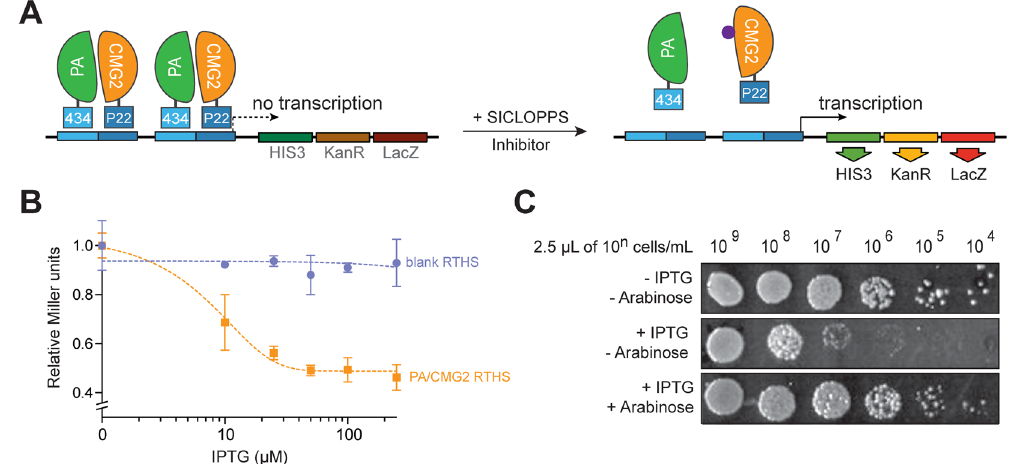
Figure 1. PA/CMG2 reverse two-hybrid system. ( A ) PA 488–735 is expressed as a fusion with the 434 bacteriophage DNA binding protein and CMG2 38–218 is expressed as a fusion with a chimeric P22 DNA binding protein. These proteins associate to form a functional repressor that prevents transcription of the 3 reporter genes (HIS3, KanR and LacZ) downstream of the operator sites, leading to cell death on selective media. In the presence of an inhibitor of the PA/CMG2 interaction from the SICLOPPS library, the repressor complex is disrupted, enabling expression of the reporter genes and survival of the host on selective media. ( B ) ONPG assay of the PA/CMG2 RTHS shows a loss of lacZ expression in response to increased doses of IPTG, with no such effect in the blank strain expression the repressor domains alone. Data represented as mean ± SEM. ( C ) drop spotting 10-fold serial dilutions (2.5 µ L of 10 n cells/mL) of the PA/CMG2 RTHS with a potential SCILOPPS inhibitor. In the absence of IPTG and arabinose, full growth is observed, whereas in the presence of 50 µ M IPTG growth of the RTHS is repressed by ~4 spots. In the presence of 6.5 µ M arabinose